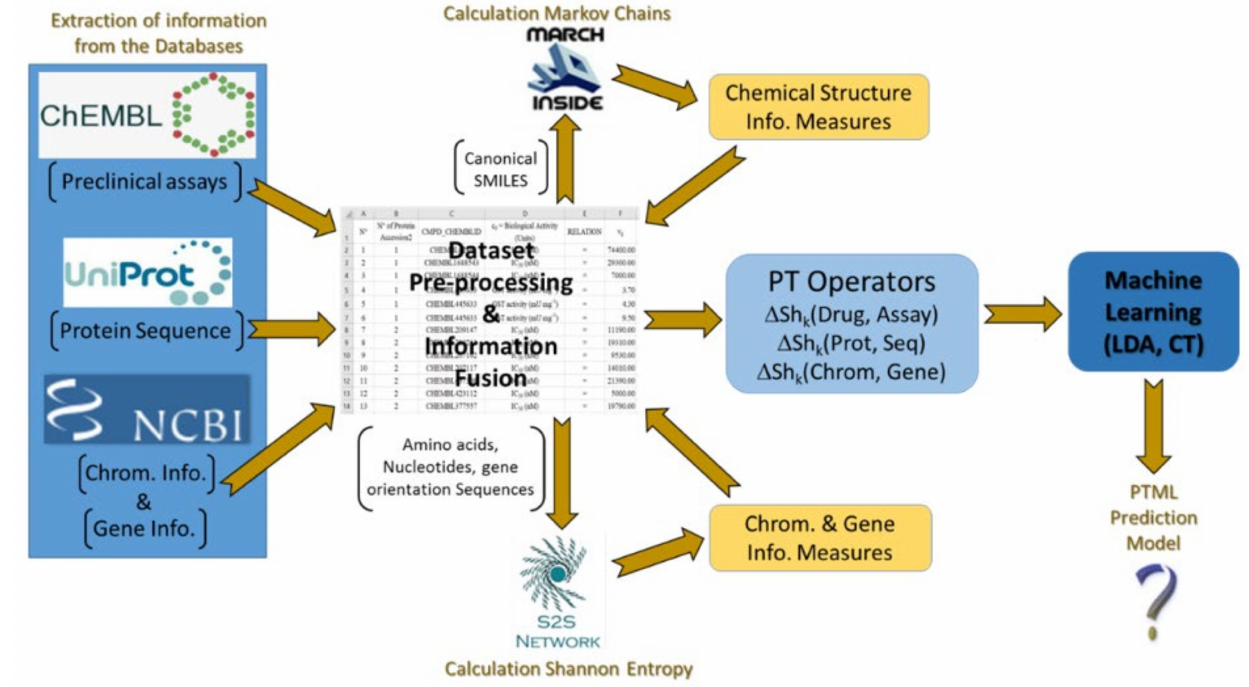
Figure 1. General Workflow of the steps given in this